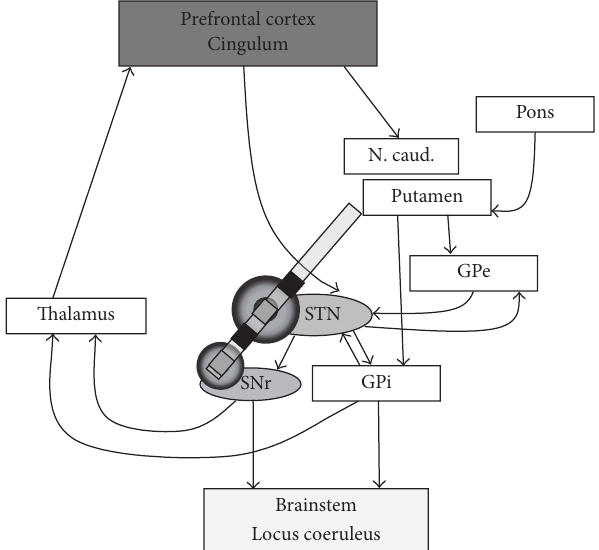
Figure 1: Simplified model of DBS induced modulation of the limbic basal ganglia loops including brainstem projections.